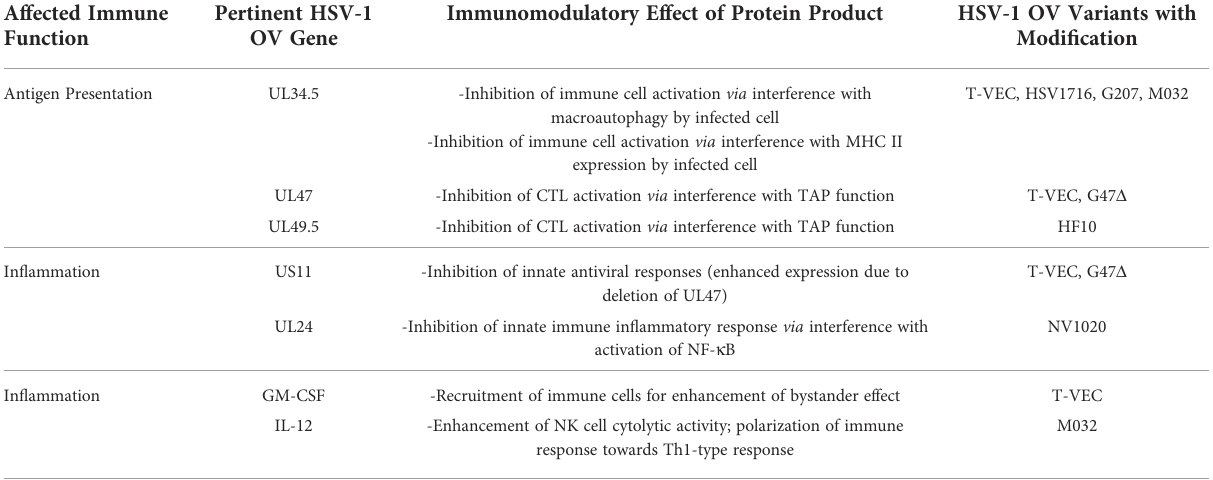
TABLE 2 Genes responsible for immunomodulatory functions found in OV variants. Affected Immune